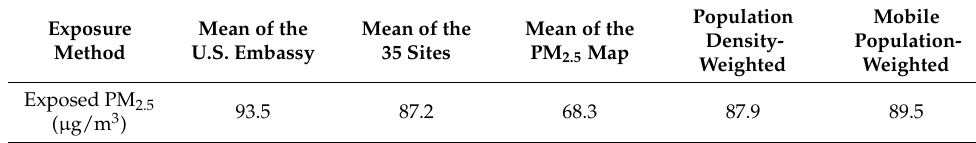
Table 4. Different measures of outdoor PM 2.5 exposure.